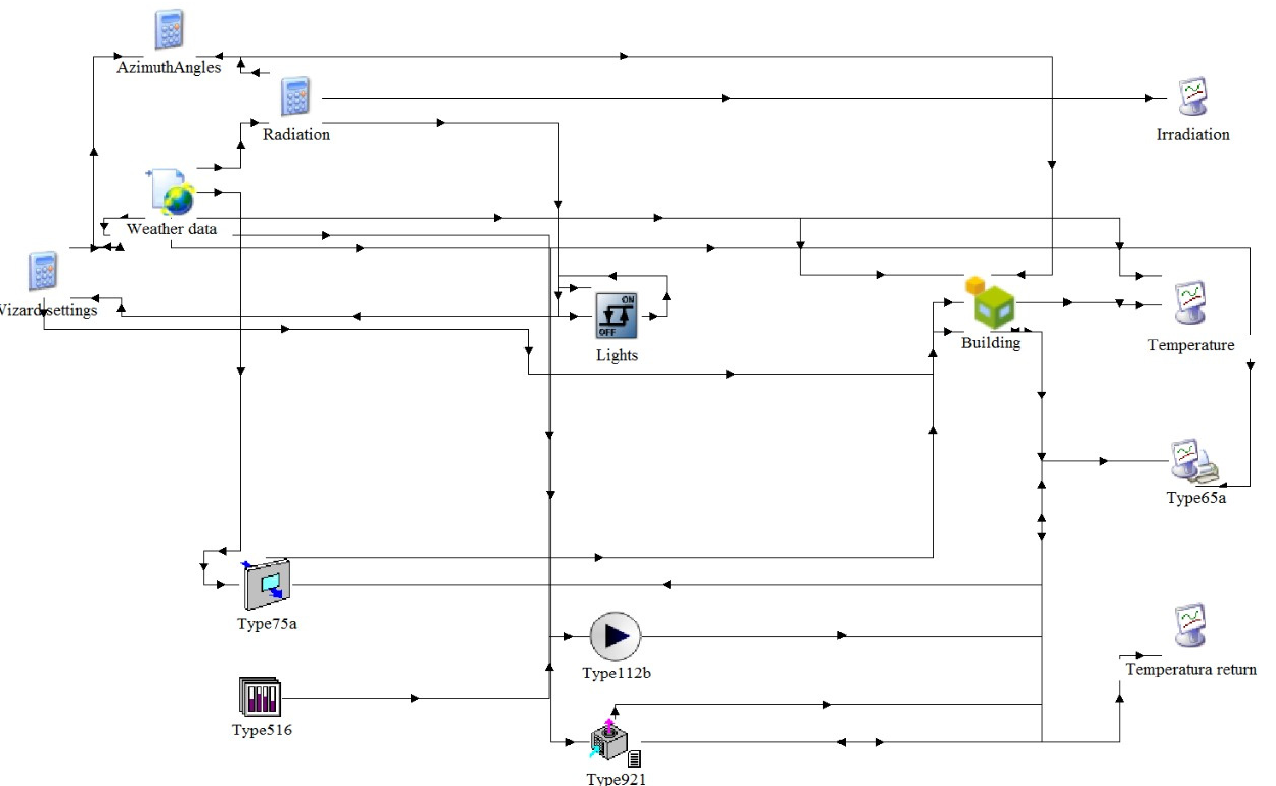
Figure 6. Building model in TRNSYS.